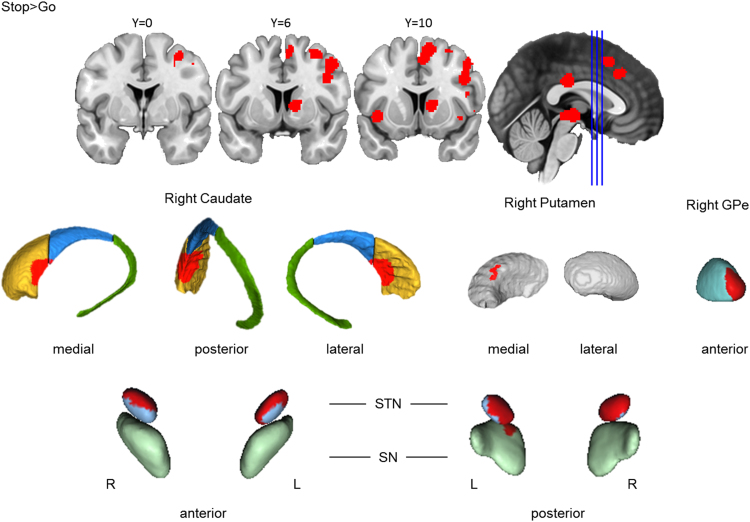
Basal ganglia activation for action cancellation. Top row: Clusters are presented on coronal slices of a high-resolution MNI atlas. Reference lines for the coronal slices are presented in the sagittal plane. Middle row: Clusters are displayed on high-resolution parcellations of the caudate, putamen, and external globus pallidus (GPe). Bottom row: Clusters are displayed on high-resolution parcellaions of the subthalamic nucleus (STN) and substantia nigra (SN). All clusters are thresholded using cluster-level inference (p<.05, uncorrected p<.001, threshold permutations=1000).